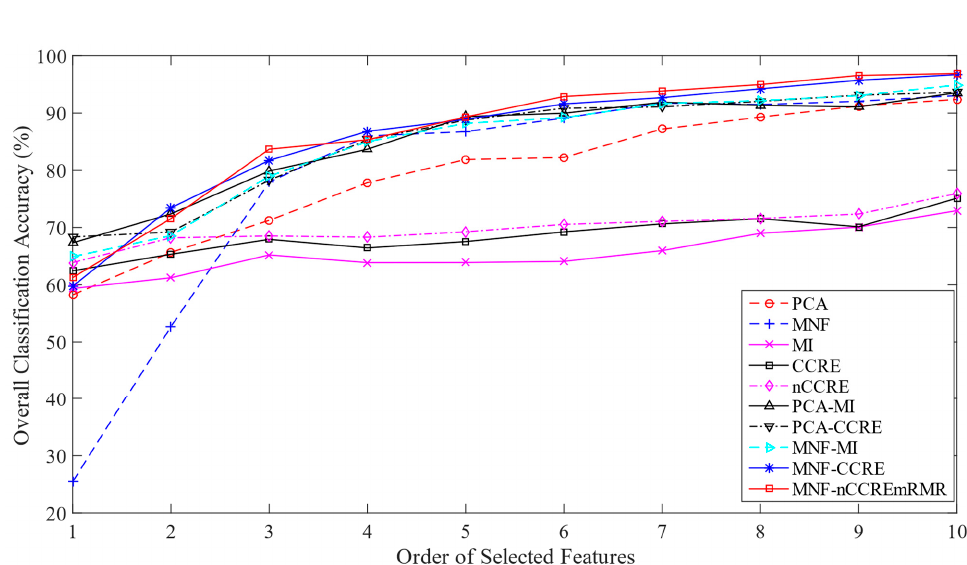
Figure 6. Classification performance measure (%) on the AVIRIS IP HSI. Table 9. Classification performance measure (%) on the AVIRIS IP HSI.